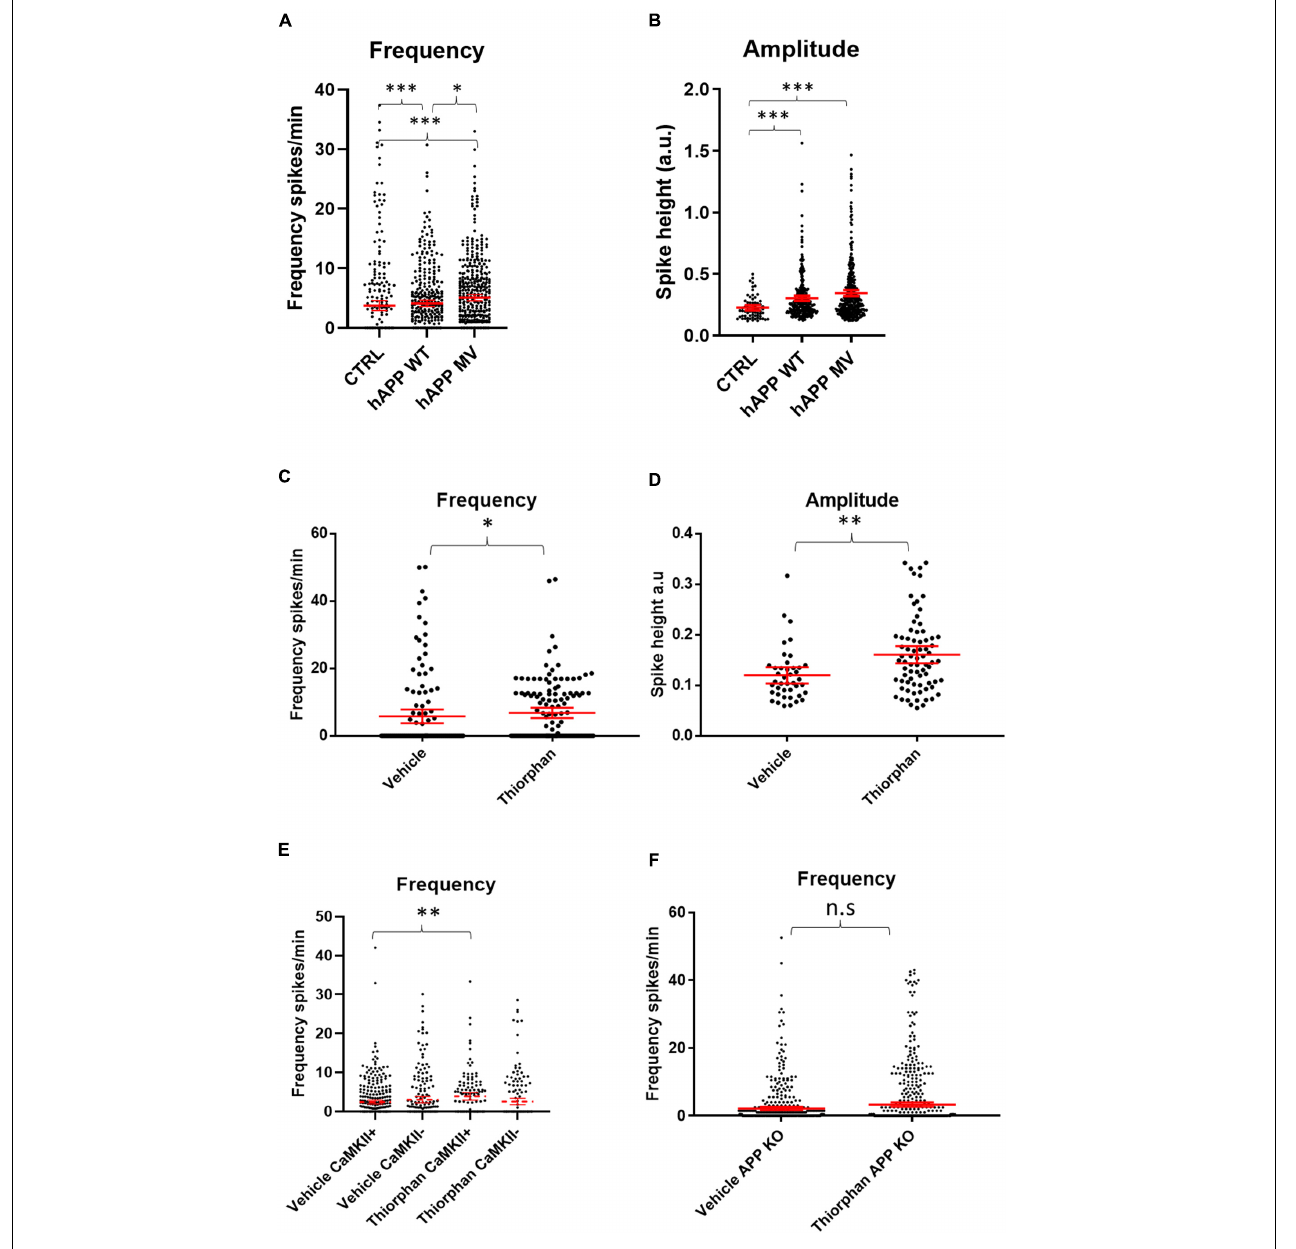
FIGURE 4 | Amyloid precursor protein and A β increase calcium oscillation frequency and amplitude. (A) Graph depicts firing frequencies in WT neurons transduced with a viral vector harboring hAPPwt or hAPPmv (BACE cleavage resistant) under a CaMKII promoter. Note that both hAPPwt and hAPPmv increase the firing frequency compared to control (CTRL), with hAPPmv having a stronger effect [hAPPmv mean = 5.087, CI = 4.542–5.633, n = 436; hAPPwt mean = 4.112, CI = 3.585–4.640, n = 375 and CTRL mean = 3.757, CI = 2.925–4.588, n = 292, p -values respective to CTRL = hAPPmv = 0.0001, hAPPwt = 0.0001, p -value hAPPmv compared to hAPPwt ( p = 0.0259), Kruskal–Wallis Dunn’s correction]. (B) Graph showing increased amplitude in neurons expressing hAPPwt and hAPPmv under CaMKII promoter (hAPPmv mean = 0.3444, CI = 0.3197–0.3691, n = 344 and hAPPwt mean = 0.3021, CI = 0.2808–0.3433, n = 278 and CTRL mean = 0.2256, CI = 0.2034–0.2479, n = 67, N = 3, p -values respective to CTRL; hAPPmv = 0.0001, hAPPwt = 0.0004, p -value, Kruskal–Wallis Dunn’s correction). Kruskal–Wallis test with Dunn’s correction for multiple comparisons. (C) WT neurons treated with 500 nM of the neprilysin inhibitor thiorphan for 1 h show increased firing frequency (thiorphan mean = 6.814, CI = 5.283–8.344, n = 133, compared to vehicle mean = 5.783, CI = 3.749–7.817, n = 125, N = 3, p = 0.0101). (D) The graph depicts increased spike amplitudes after 1 h of treatment of WT neurons with thiorphan (thiorphan mean = 0.1605, CI = 0.1436–0.1774, n = 76, compared to vehicle mean = 0.1198, CI = 0.1036–0.136, n = 42, p = 0.0012). (E) Graph showing increase in spike frequency of thiorphan treated CaMKII positive compared to vehicle treated CaMKII positive neurons (thiorphan mean = 3.905, CI = 2.942–4.869, n = 128 compared to vehicle mean = 2.432, CI = 1.934–2.931, n = 332, N = 3, p = 0.0089). In contrast, spike frequency of CaMKII negative thiorphan treated neurons did not significantly differ from vehicle treated CaMKII negative neurons (thiorphan mean = 2.566, CI = 1.726–3.406, n = 173 compared to vehicle mean = 3.018, CI = 2.243–3.794, n = 218, p = 0.0894). (F) Graph showing that thiorphan was ineffective at inducing increased frequency in APP KO neurons compared to vehicle (APP KO thiorphan mean = 3.329, CI = 2.692–3.967, n = 601 compared to APP KO vehicle mean = 2.196, CI = 1.689–2.704, n = 514, N = 3, p = 0.8604, Mann–Whitney U -test).; n.s = not significant, ∗ p < 0.05, ∗∗ p < 0.01, ∗∗∗ p < 0.001.